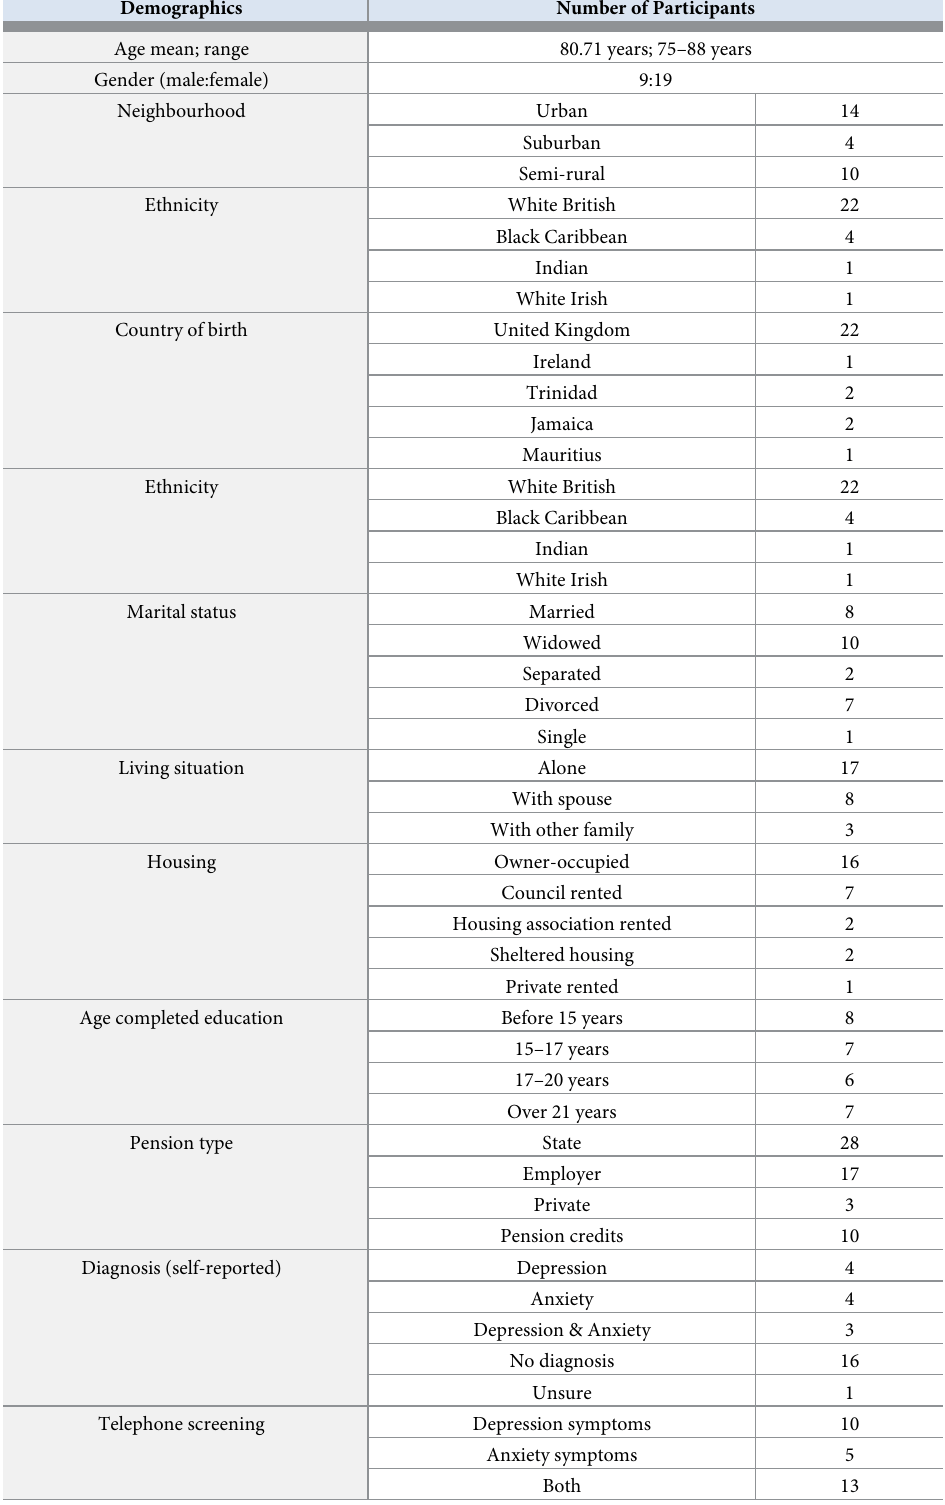
Table 1. Demographic characteristics of study